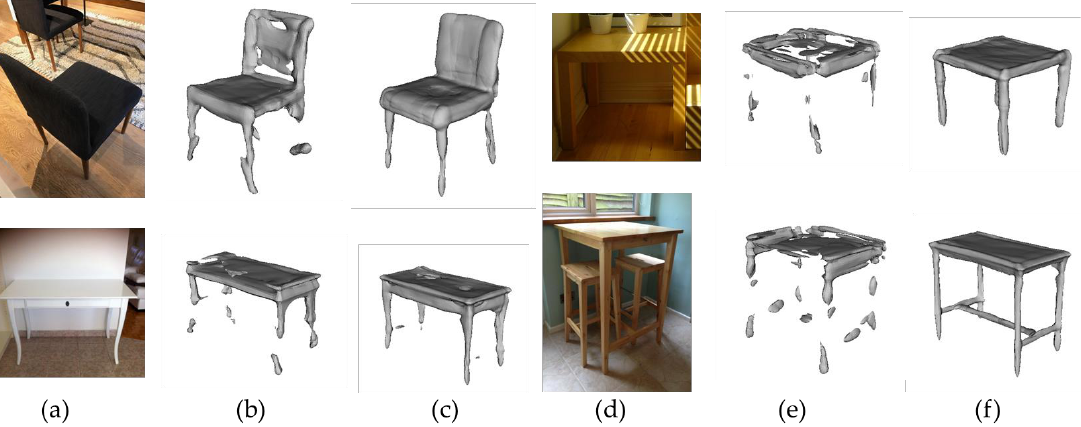
Figure 7. Mesh reconstruction results of single images captured under constrained conditions. ( a , d ) input images; ( b , e ) rendered images of reconstructed meshes produced using Implicit3D; ( c , f ) ren- dered images of reconstructed meshes produced using the